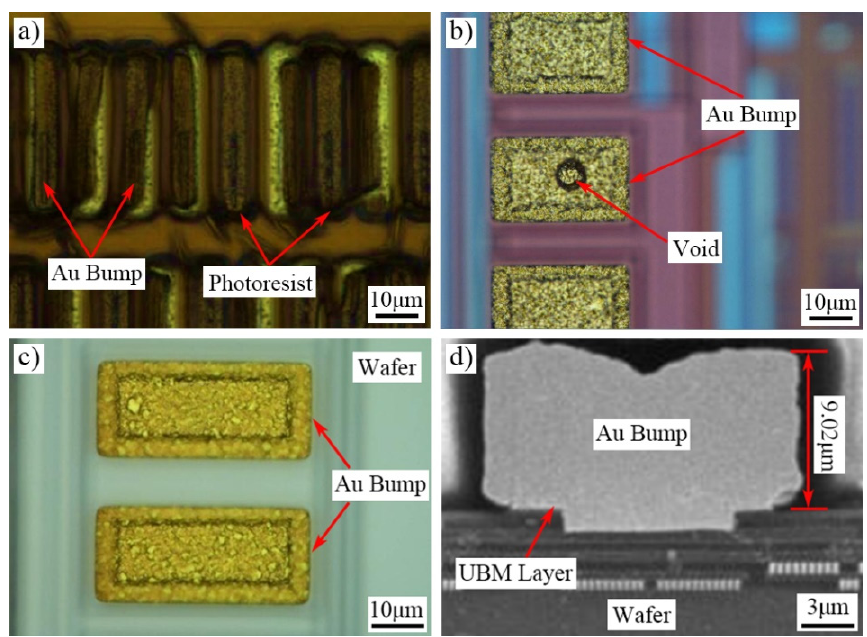
Figure 13. Morphology of Au bump. ( a ) Photoresist burning, ( b ) Void, ( c ) Top view of optimized Au bump, ( d ) Cross-section view of optimized Au bump.